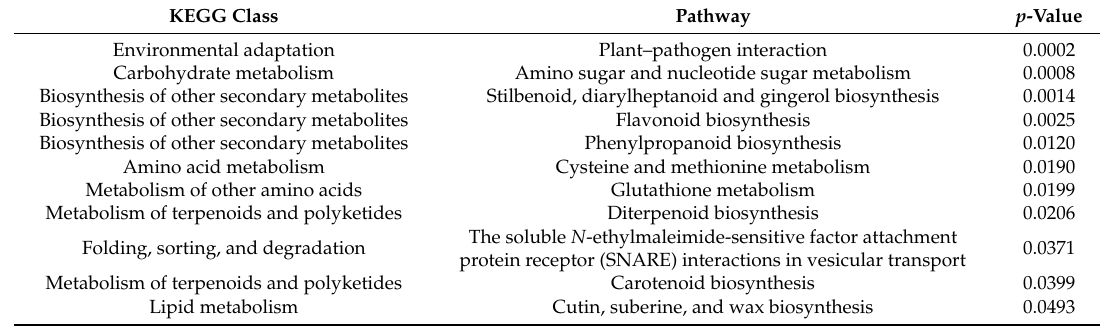
Table 2. KEGG terms enriched among downregulated DEGs specific to the PS vs. PT comparison.